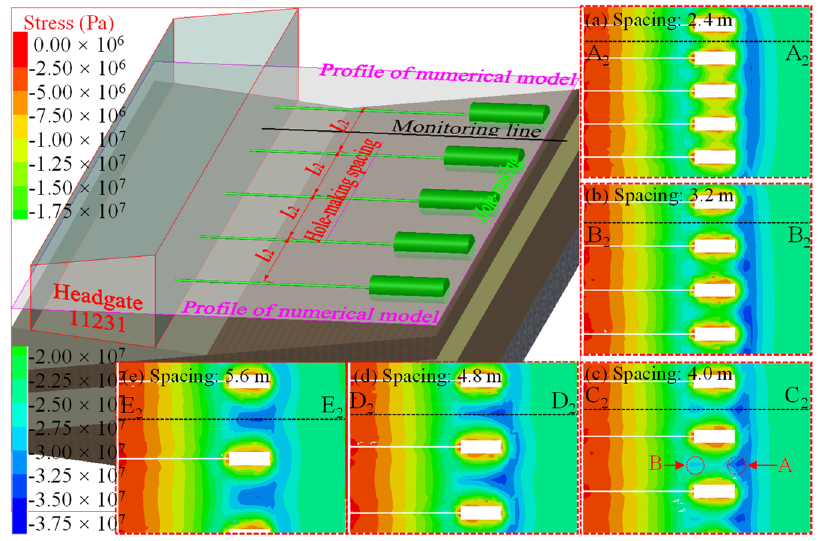
Figure 11. Layout scheme under different hole-making spacing and distribution nephogram of vertical stress.